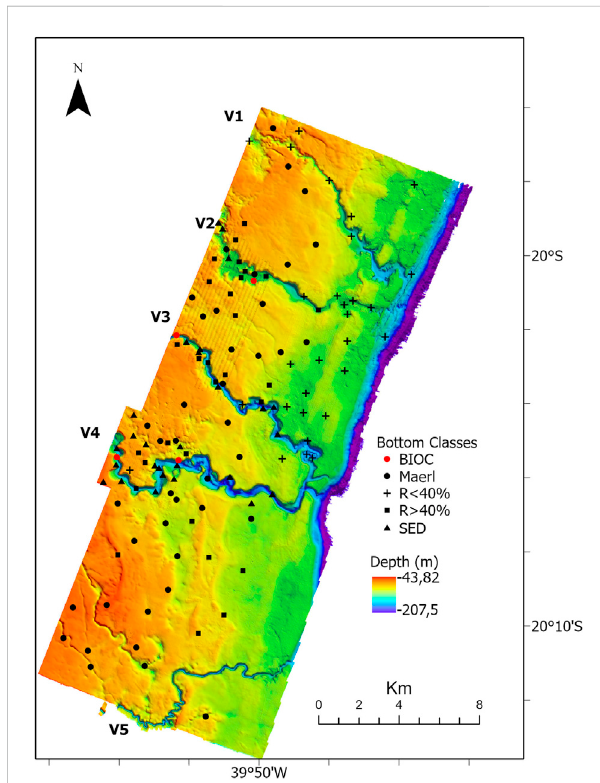
FIGURE 3 Shelf morphology highlighting the fi ve shelf-incised valleys. Locations of classi fi ed seabed images de fi ned from the dropcams are also shown. Bioincrustations (BIOC- rigid bottom with benthic cover); Unconsolidated sediment (SED-unconsolidated fi ne and coarse sediments); Rhodoliths (R > 40% - > 40% of the frame covered